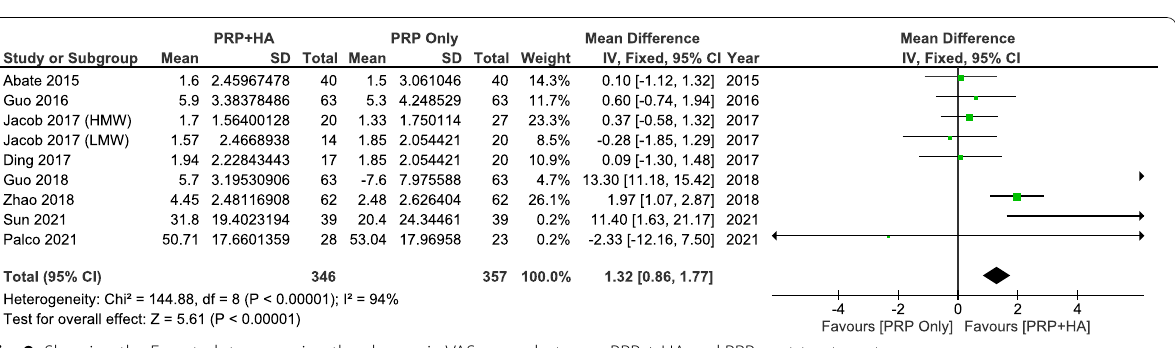
scores than those who received PRP only at 6 months (SMD: 5.02, 95% CI: 1.36 to 8.67, P A comparison of IKDC scores between PRP combined with HA and PRP pre-treatment and post-treatment showed a mean improvement of